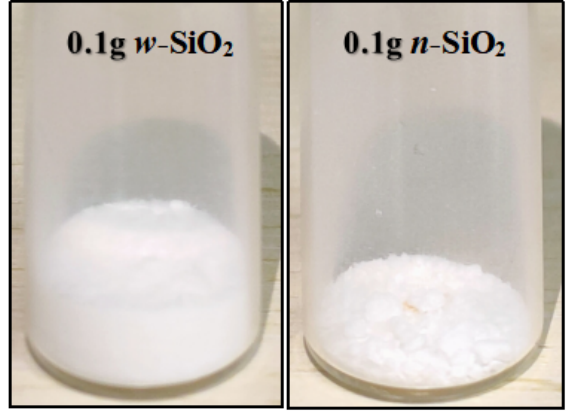
Figure 1. Images of w -SiO 2 and n -SiO 2 samples.